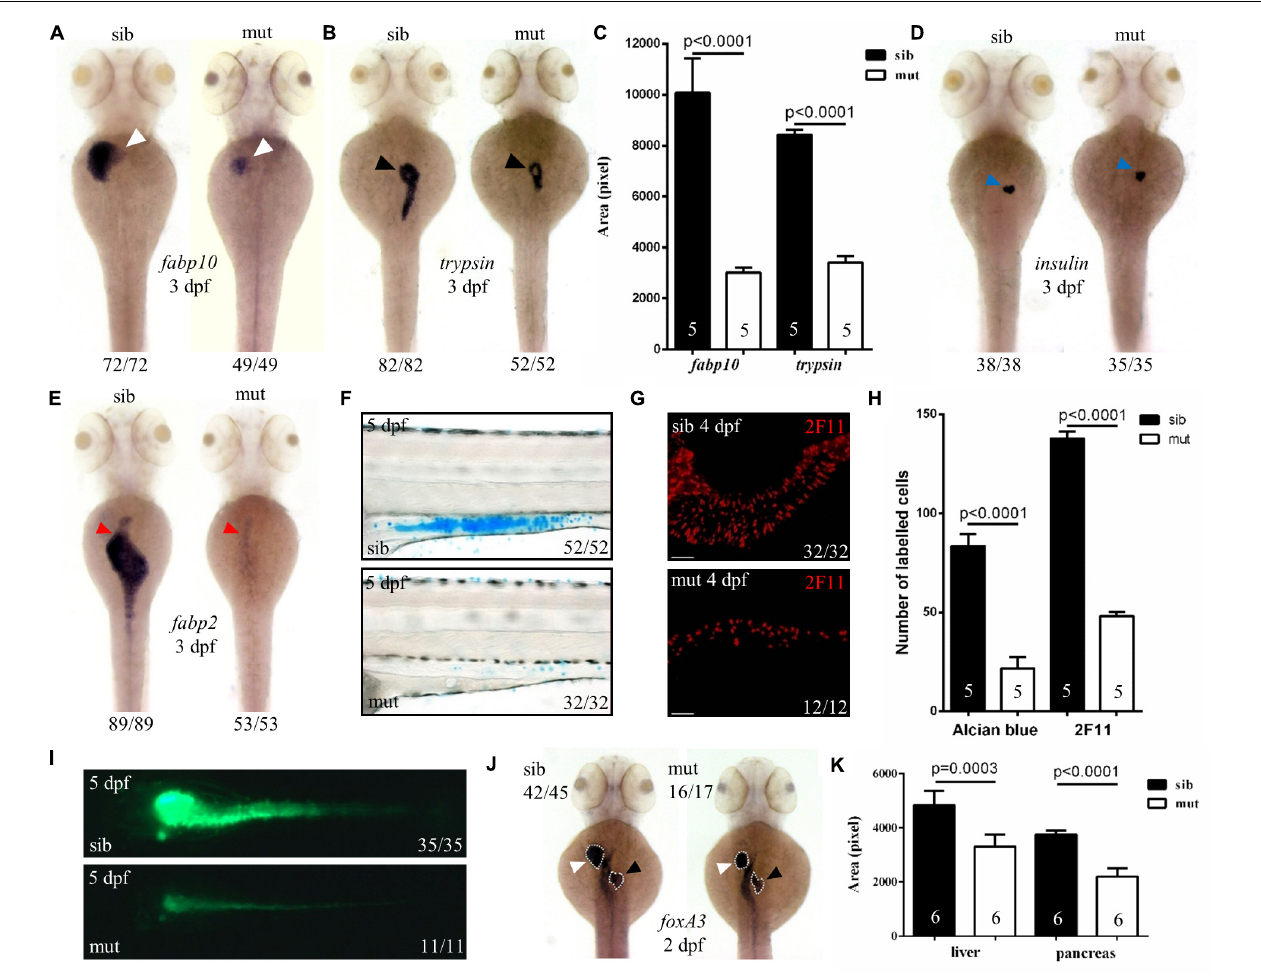
FIGURE 2 | Defects in the development of digestive organs in ltv1 ∆ 14 /∆ 14 mutant. (A,B,D,E) WISH using the hepatocyte marker fabp10 , acinar cell marker trypsin , beta cell marker insulin , and enterocyte marker fabp2 at 3 dpf. (C) Quantification of fabp10 (siblings, N = 5; mutants, N = 5) or trypsin (siblings, N = 5; mutants, N = 5) positive area in panel (A) or (B) , respectively. Bars represent means with SD. (F) Alcian blue-stained goblet cells at 5 dpf. (G) Enteroendocrine cells (2F11 + ) in the intestine bulb at 4 dpf. (H) Quantification of Alcian blue-stained (siblings, N = 5; mutants, N = 5) or 2F11-positive (siblings, N = 5; mutants, N = 5) cells in panel (F) or (G) , respectively. Bars represent means with SD. (I) Gut lumen labeled by DCFH-DA at 5 dpf. (J) WISH using the pan-endodermal marker foxA3 at 2 dpf. (K) Quantification of the liver and pancreas area labeled by foxA3 (siblings, N = 6; mutants, N = 6) in panel (J) . Bars represent means with SD. White arrowhead: liver; black arrowhead: exocrine pancreas; blue arrowhead: endocrine pancreas; red arrowhead: